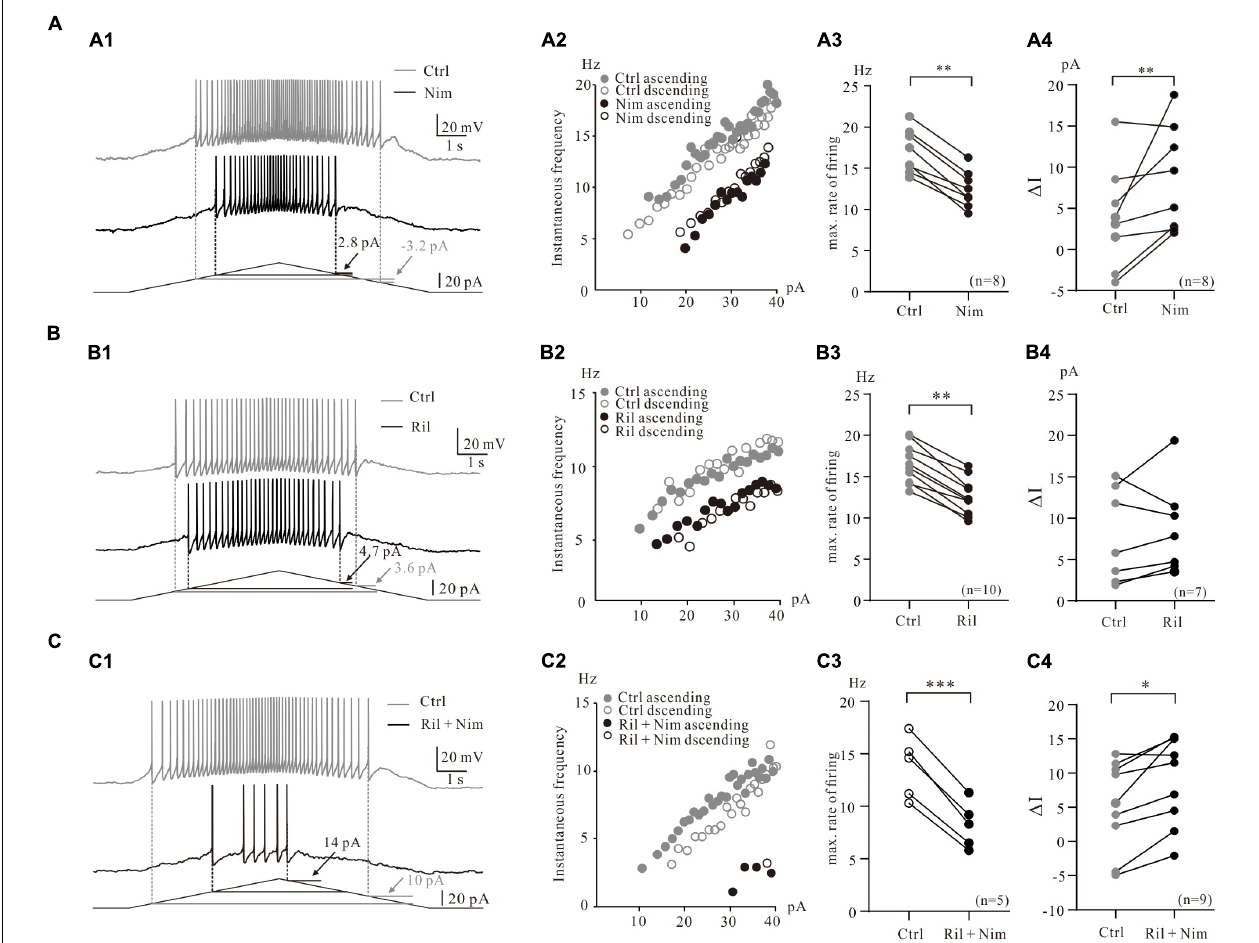
FIGURE 3 | Contribution of multiple PICs to the firing properties of 5-HT neurons. (A) Contribution of Ca_PIC to the firing properties of 5-HT neurons. (A1) Overlapped voltage traces recorded by current ramp in control (gray) and application of 25 µ M nimodipine (black). (A2) Instantaneous firing frequency/current relationship (iF-I relation) for both control and nimodipine condition. Depolarizing phase of the ramp represented by closed circles (control, gray closed circles; nimodipine, black closed circles) and repolarizing phase represented by open circles (control, gray open circles; nimodipine, black open circles). (A3) Graphs show the maximal frequency in control (gray circles) and in the presence of 25 µ M nimodipine (black circles). (A4) Graphs show the (cid:49) I in control (gray circles) and in the presence of 25 µ M nimodipine (black circles). (B) The effects of Na_PIC on the firing properties of 5-HT neurons. (B1) Overlapped voltage traces recorded by current ramp in control and application of 2 µ M Riluzole. (B2) Instantaneous firing frequency/current relationship for both control (gray circles) and Riluzole (black circles) condition. (B3) Graphs show the maximal frequency in control (gray circles) and in the presence of 2 µ M Riluzole (black circles). (B4) Graphs show the (cid:49) I in control (gray circles) and in the presence of 2 µ M Riluzole (black circles). (C) Contribution of TDR_PIC to the firing properties. (C1) Overlapped voltage traces recorded by current ramp in control and application of 2 µ M Riluzole and 25 µ M nimodipine. (C2) Instantaneous firing frequency/current relationship for both control (gray circles) and Riluzole and Nimodipine (black circles) condition. (C3) Graphs show the maximal frequency in control (gray circles) and in the presence of 2 µ M Riluzole and 25 µ M nimodipine (black circles). (B4) Graphs show the (cid:49) I in control (gray circles) and in the presence of 2 µ M Riluzole and 25 µ M nimodipine (black circles). Error bars show SD. ∗ P < 0.05, ∗∗ P < 0.01, ∗∗∗ P < 0.001, paired t -test.